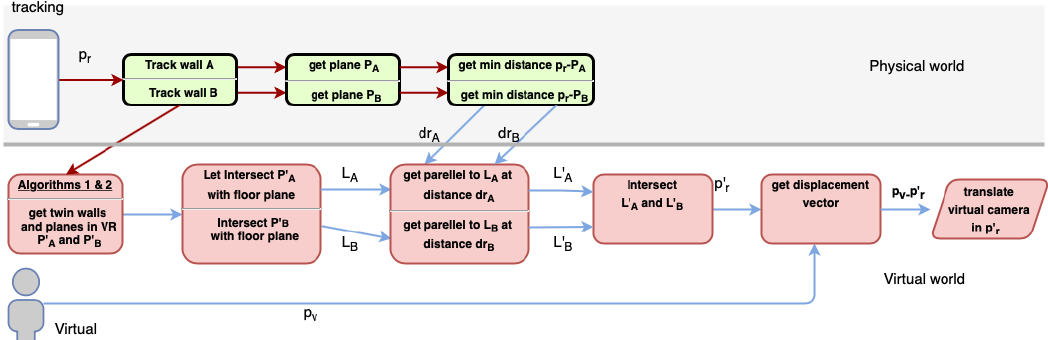
Figure 10. Workflow to correct the user position in the virtual